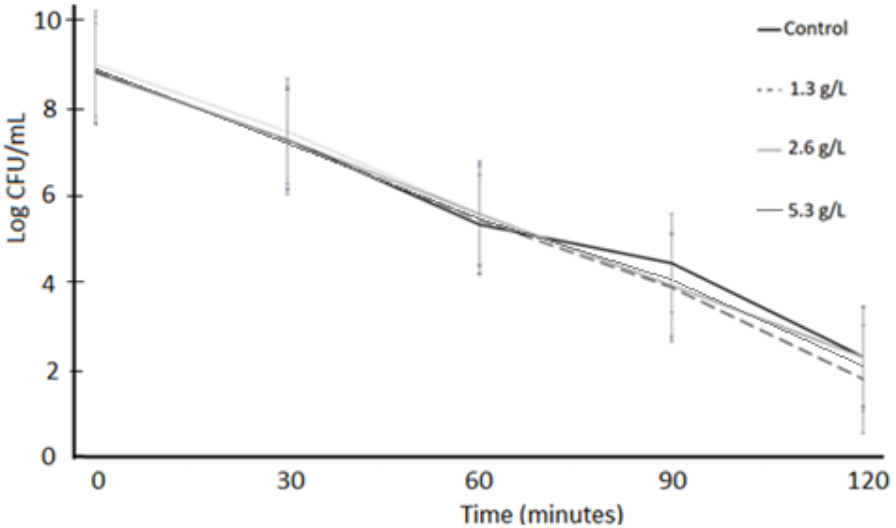
Figure 4. Log counts of L. bulgaricus to show acid tolerance as influenced by carao concentration over an incubation period of 120 min.